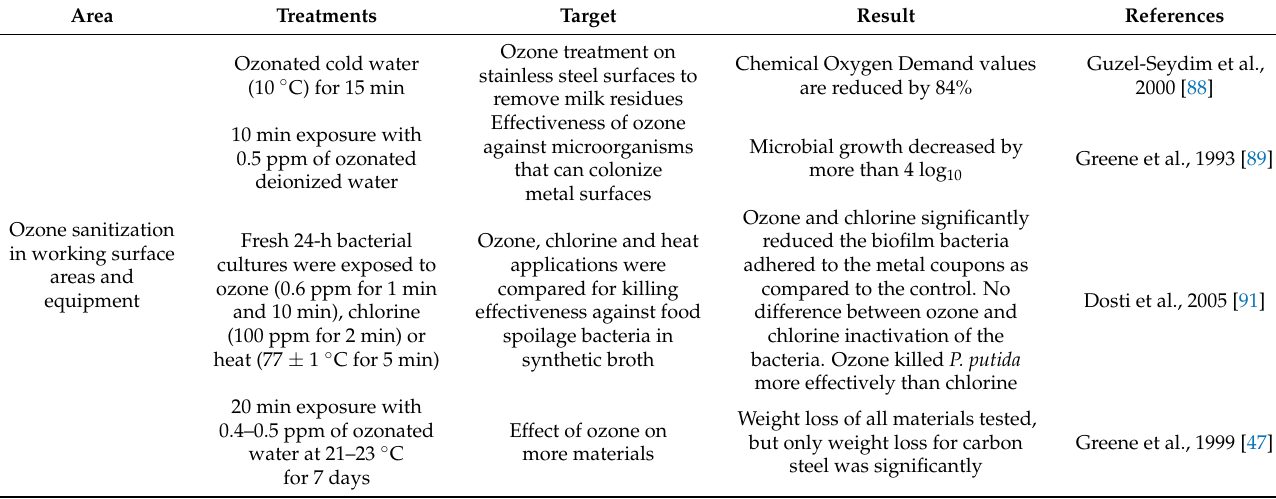
Table 3. Ozone sanitization in working surface areas and